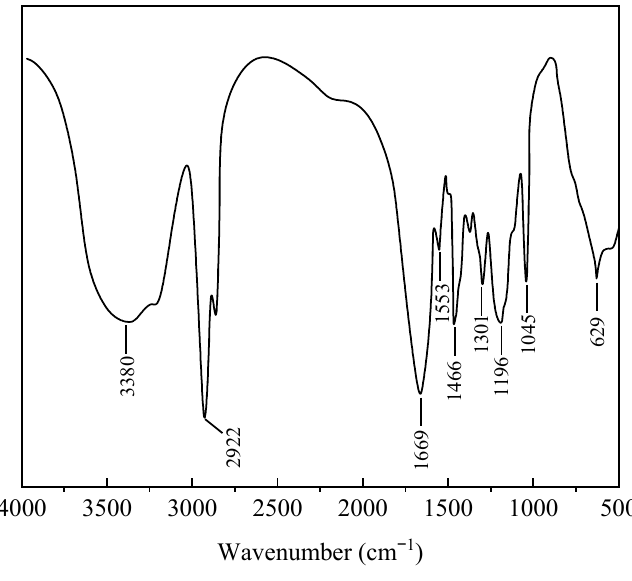
Figure 6. Infrared Spectrum of polymeric microspheres.